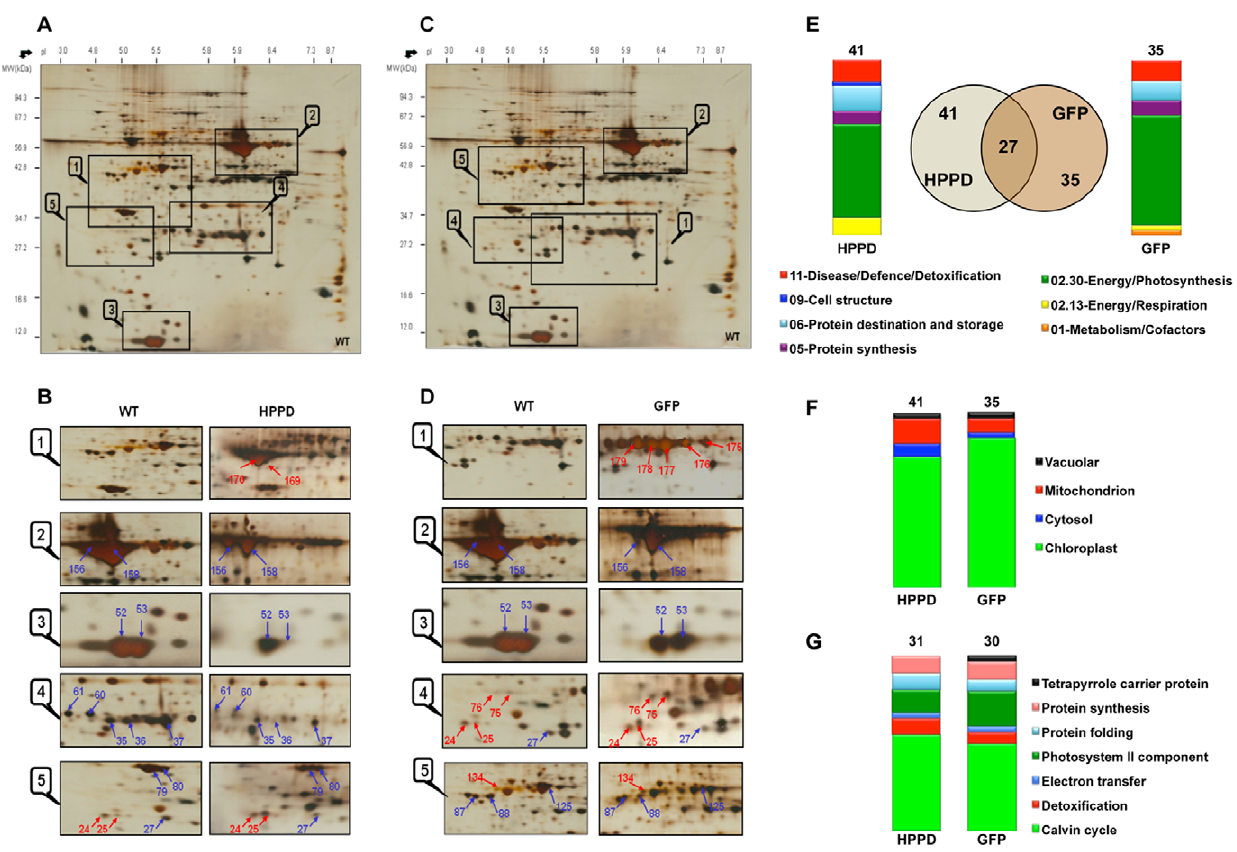
Figure 2. Influence of a massive recombinant protein accumulation on the proteome of tobacco leaves. (A, C) Representative silver- stained 2D gel of total soluble leaf proteins from wild type (WT) plants. (B) Enlarged windows (1–5) of 2D gels as shown in (A) for wild type plants (left) and HPPD transformants (right). (D) Enlarged windows (1–5) of 2D gels as shown in (C) for wild type plants (left) and GFP transformants (right). The numbers assigned to the proteins spots correspond to those listed in Table S2 and depicted in Figure S1. Red and blue arrows indicate protein spots that were up or down accumulated, respectively, in leaves of transplastomic tobaccos compared with wild type plants. (E) Venn diagram of varying proteins from HPPD and/or GFP transformants and functional categories assigned to the varying proteins from HPPD (41 proteins) or GFP (35 proteins) transformants, respectively. (F) Subcellular localization of the differentially expressed proteins in leaves of HPPD and GFP transformants. (G) Functional classification of varying proteins localized in chloroplasts from HPPD and GFP